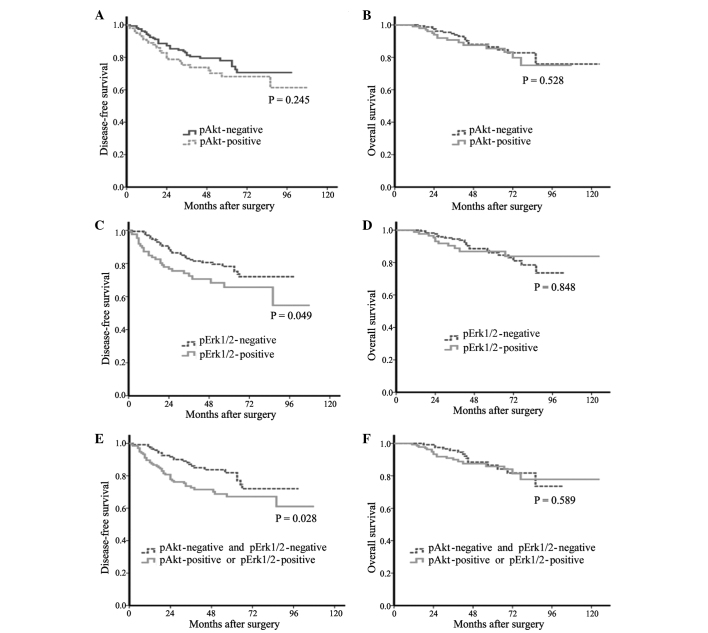
(A) Disease-free and (B) overall survival of patients with pAkt-negative versus pAkt-positive tumors. (C) Disease-free and (D) overall survival of patients with pErk1/2-negative versus pErk1/2-positive tumors. (E) Disease-free and (F) overall survival of patients with pAkt-negative and pErk1/2-negative versus pAkt-positive/pErk1/2-positive tumors. pAkt, phosphorylated Akt; pEkr1/2, phosphorylated extracellular-regulated kinase 1/2.